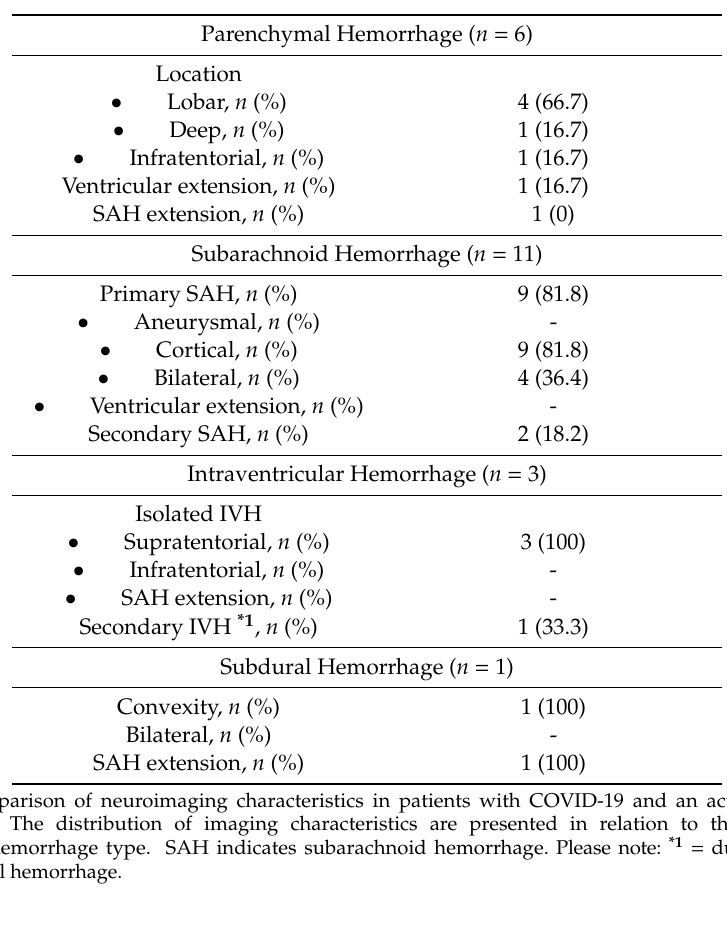
Table 2. Neuroimaging characteristics of patients with COVID-19.